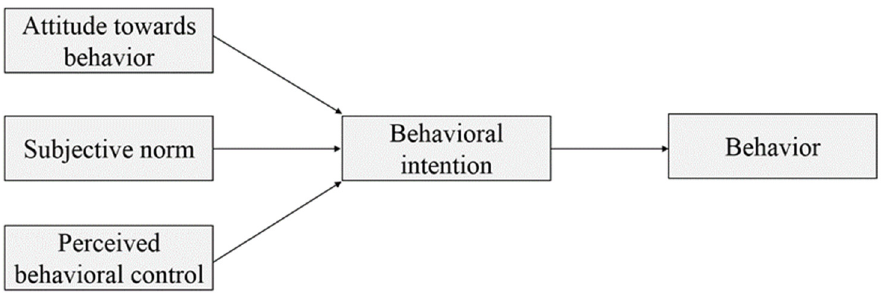
Figure 1. Theoretical model of Theory of Planned Behavior (Ajzen, 1991).